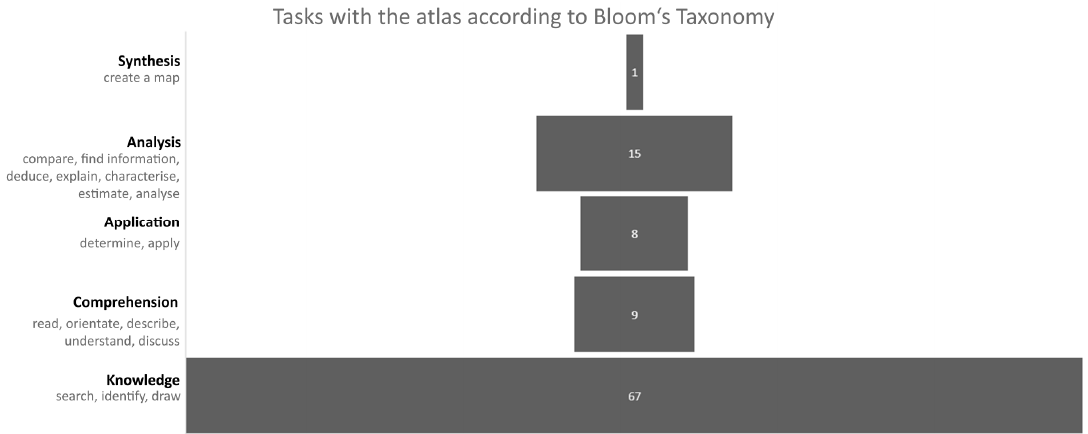
Figure 8. Classification of tasks used with an atlas according to Bloom’s taxonomy.